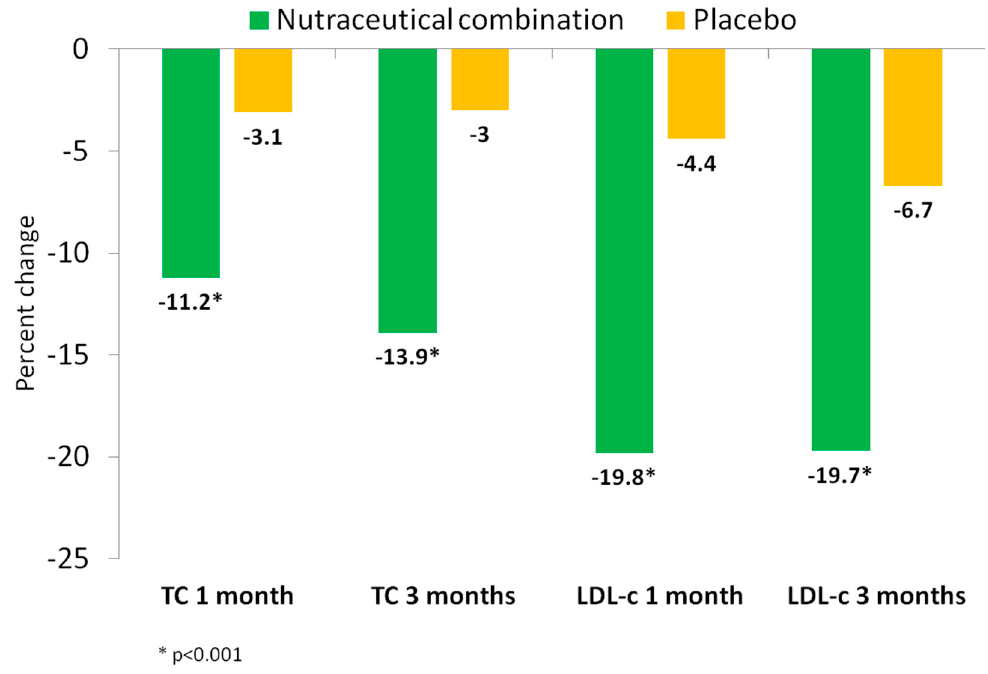
Figure 2. Percent reduction of plasma total cholesterol and LDL-cholesterol by treatment group: Nutraceutical (green), control (yellow). TC: total-cholesterol; LDL: low density lipoprotein.